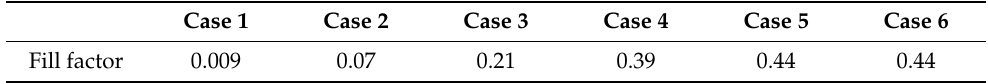
Table 6. Fill factor values for six shading cases.